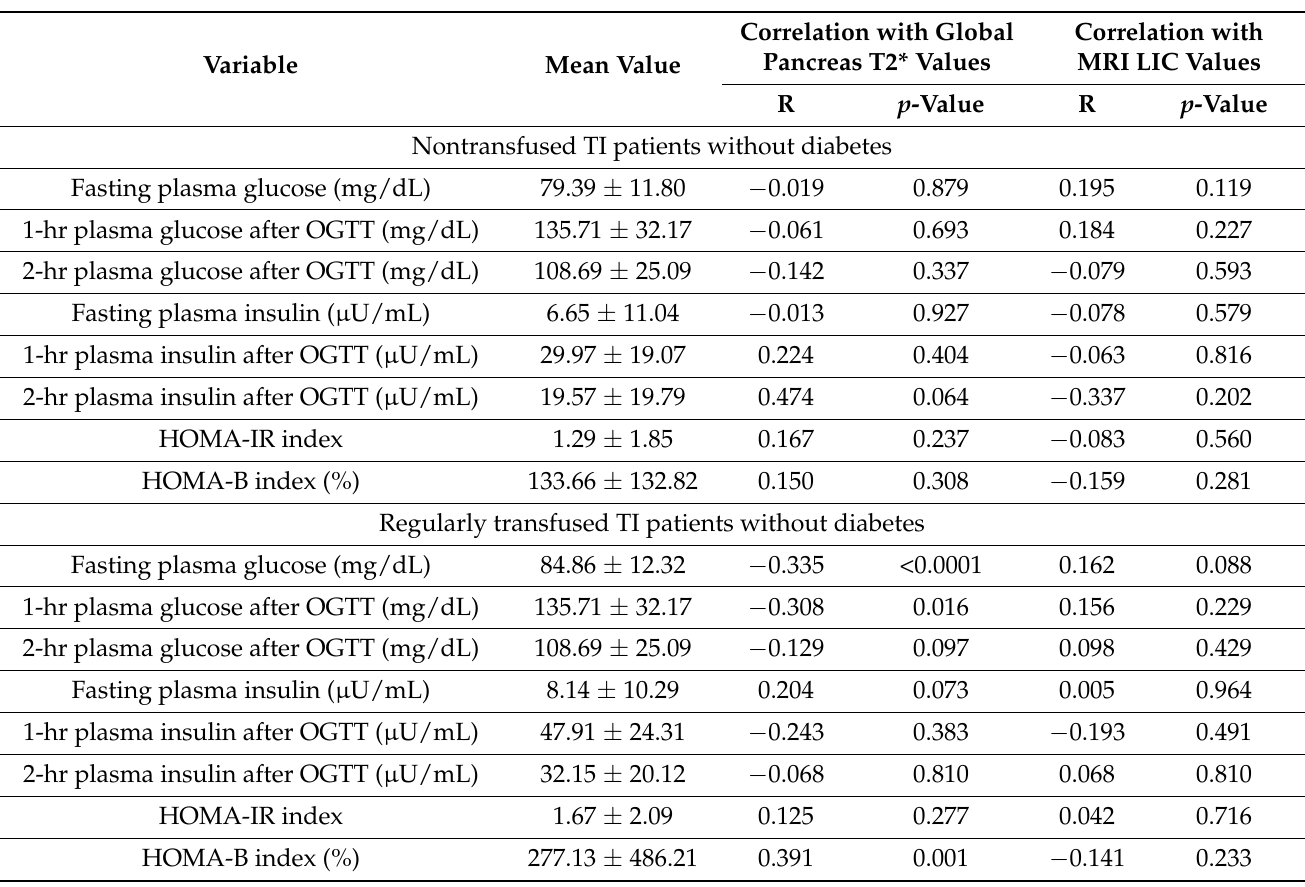
Table 2. Association of pancreas T2* values and MRI LIC values with glucose and insulin